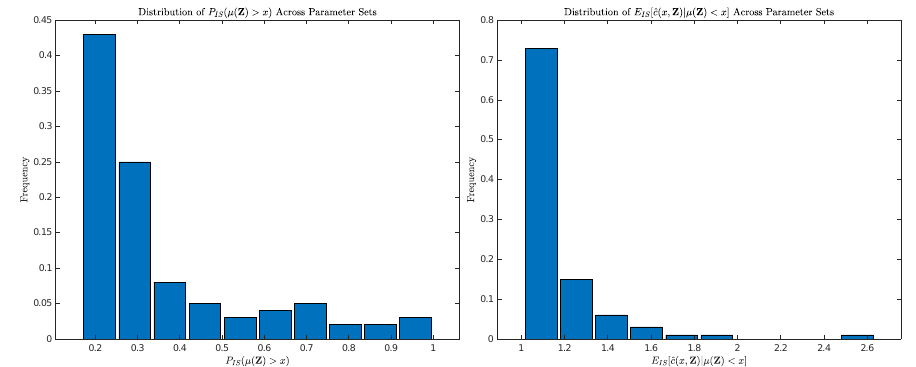
Figure 5. This figure illustrates the variation of P IS ( µ ( Z ) < x ) (left panel) and E IS [ ˆ c ( x , Z ) | µ ( Z ) < x ] (right panel) across model parameters. Recall that the former quantity determines the frequency with which the second-stage rejection sampling algorithm must be applied and the latter quantity determines the efficiency of the algorithm when it must be applied. For each of 100 parameter sets, randomly selected according to the procedure described in Section 5.3, we compute the first-stage IS parameters and then draw 10,000 realisations of the systematic risk factors from the variance adjusted first-stage IS